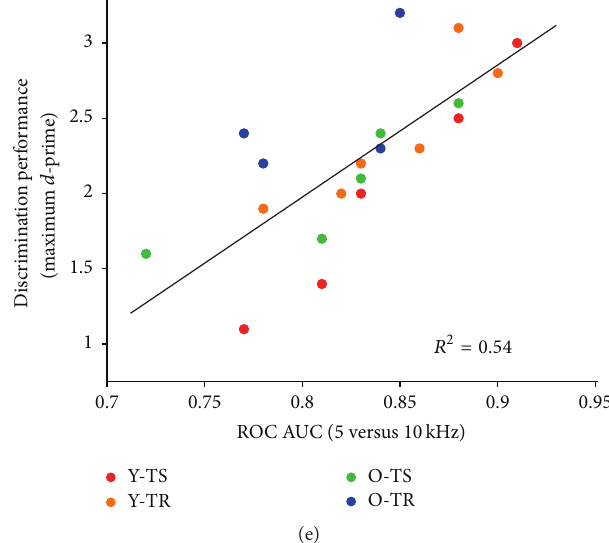
Figure 4: Training and rivastigmine impact on the overlap in A1 area responsiveness to training tones. (a) A1 maps from the same animals as in Figure 3 showing the area activated by 5kHz (blue polygons) or 10kHz (green polygons) tones presented at 60 dB SPL (the sound intensity during training). The dark pink polygons indicate the area of the map activated by both frequencies. (b) Difference in A1 area overlap in responsiveness to 5 and 10kHz ± 0.3 octaves in all groups. Note how training is associated with an overall reduction in overlap in all groups. (c) Difference in A1 area responsiveness to frequencies other than 5 or 10 kHz in all groups. Note how training resulted in a relative increase of A1 area activated by nontrained tones in all groups except O-TS where the reduction in overlap (b) was driven by a relative expansion of the area responsive to 10 kHz. (d) Left : ROC analysis demonstrating the average discriminability in the pattern of A1 activation for 5 and 10kHz tones presented at 60dB SPL. Right : ROC analysis demonstrating the average discriminability in the pattern of A1 activation for 10 and 20 kHz tones presented at 60 dB SPL. Note how training decreases the AUC in the O-TS group only. (e) Maximal performance ( d -prime) on behavioral training plotted against AUC (5 versus 10 kHz) for all groups. Scale bar represents 1mm. D: dorsal; C: caudal; R: rostral; V: ventral (Y-UT: 𝑛 = 8 , recorded sites = 435; Y-TS: 𝑛 = 5 , recorded sites = 257; Y-TR: 𝑛 = 6 , recorded sites = 312; O-UT: 𝑛 = 8 , recorded sites = 412; O-TS: 𝑛 = 5 , recorded sites = 261; O-TR: 𝑛 = 5 , recorded sites = 249). Values shown are mean ± SE. ∗ 𝑝 < 0.05 : ∗∗ 𝑝 < 0.001 : 𝑡